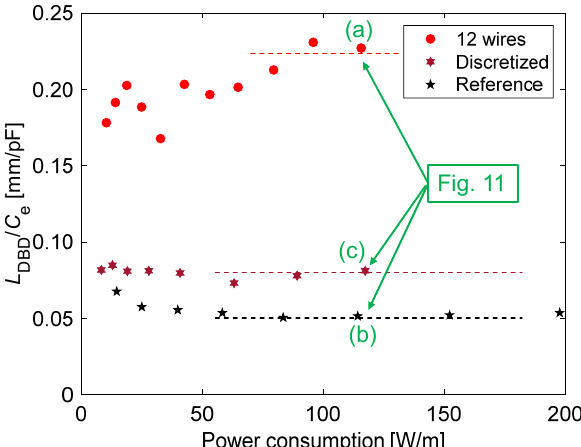
Figure 16. L DBD / C e as a function of P PA for the three PAs. Under P PA > 50 W/m, L DBD / C e approaches constant values of 0.23 mm/pF (string-array-type, 12 wires), 0.05 mm/pF (reference), and 0.08 mm/pF (discretized). Three conditions (a), (b), and (c) indicated by the arrows correspond to those under which discharge images for analyzing L DBD were acquired in Figure 11.